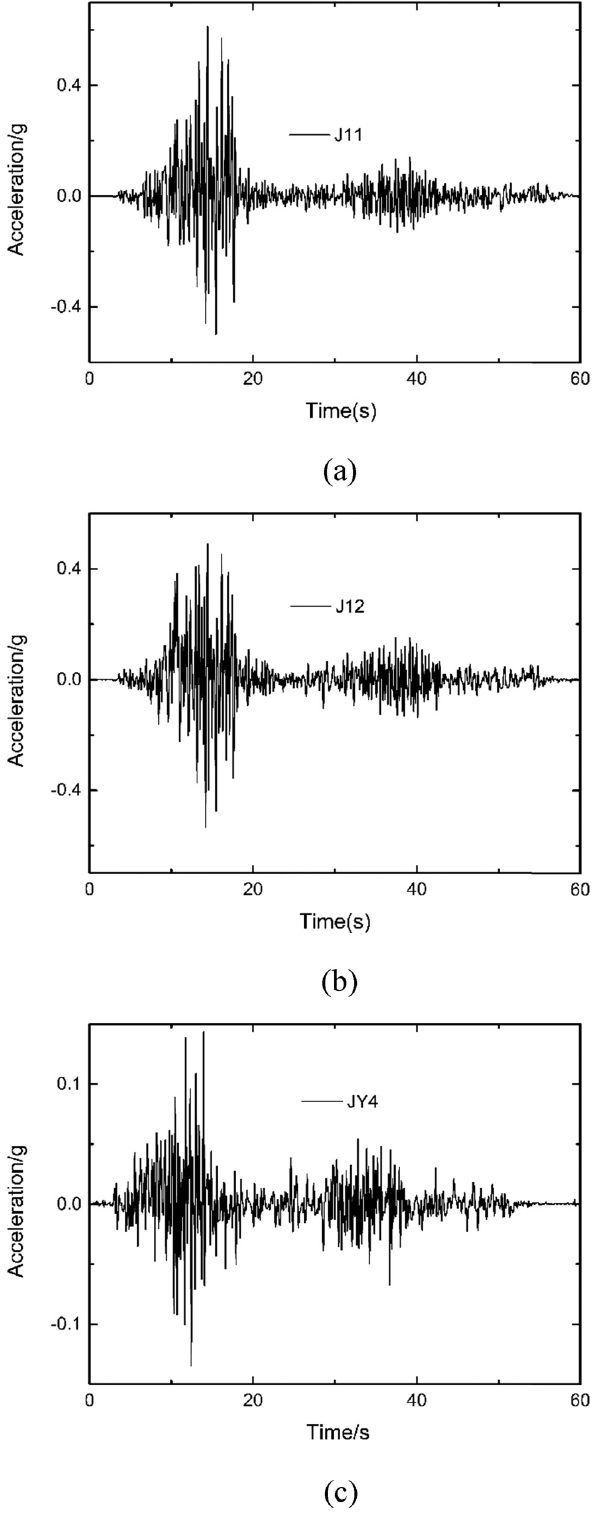
Figure 9: Acceleration time - histories of dam crest subject